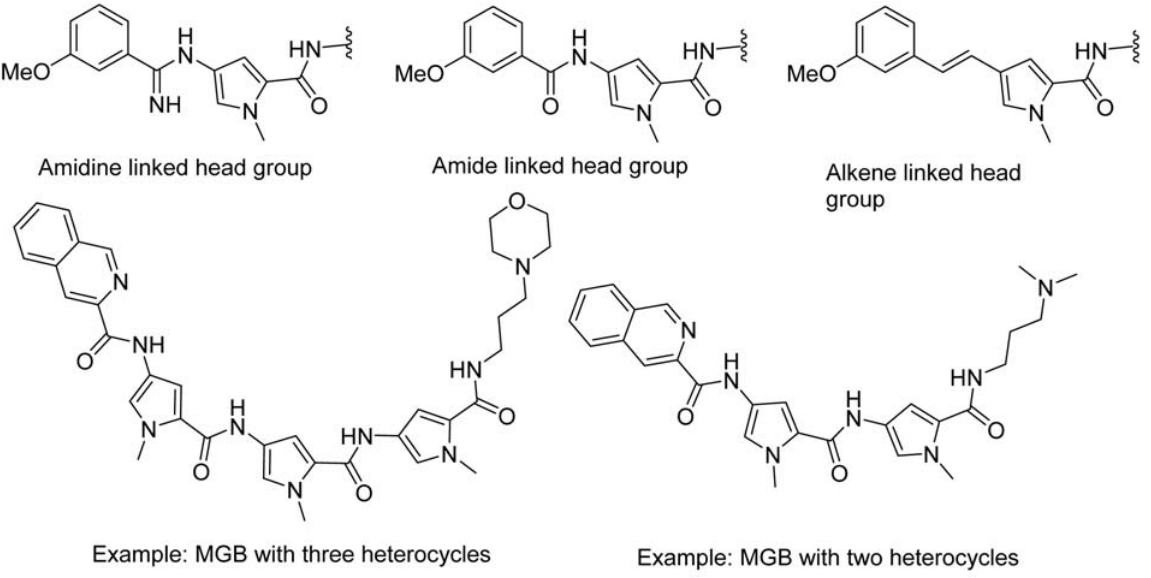
Figure 5. Exemplars of the types of MGBs investigated in reference 46